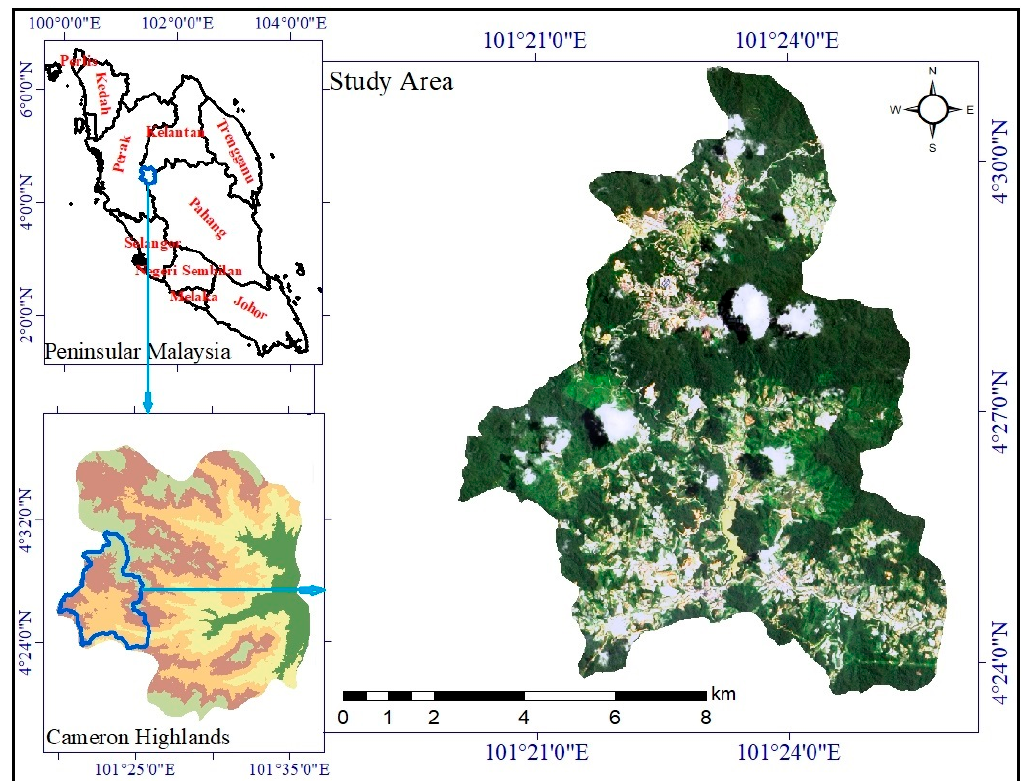
Figure 1. Geographical extend of the study area.